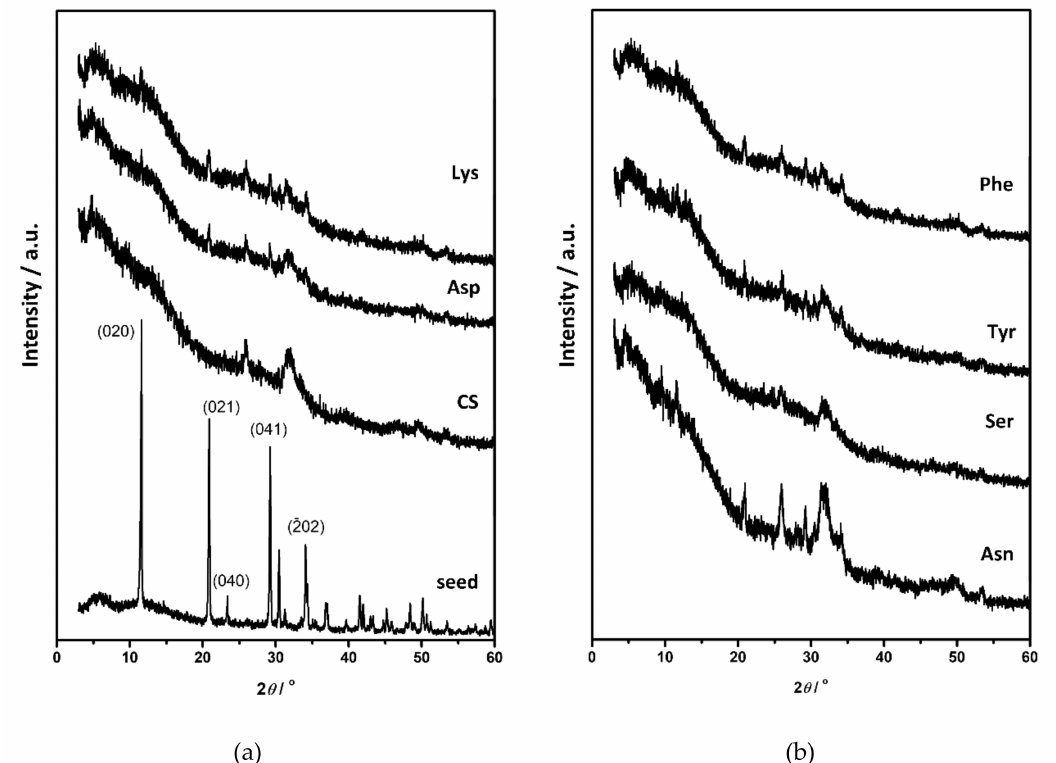
Figure 7. PXRD di ff ractograms of ( a ) calcium hydrogenphosphate dihydrate (DCPD) seed crystals and precipitates formed in the control system (CS) and in the presence of aspartic acid (Asp) and lysine (Lys), ( b ) precipitates obtained in the presence of asparagine (Asn), serine (Ser), tyrosine (Tyr) and phenylalanine (Phe) after 240 min aging time in the system c (CaCl 2 ) = c (Na 2 HPO 4 ) = 4.198 mmol dm − 3 , c (NaCl) = 0.148 mol dm − 3 , m (seed DCPD) = 1 mg, γ (AA) = 10 ppm, except γ (Phe) = 5 ppm. t = 25 ◦ C, pH initial = 7.4, magnetic